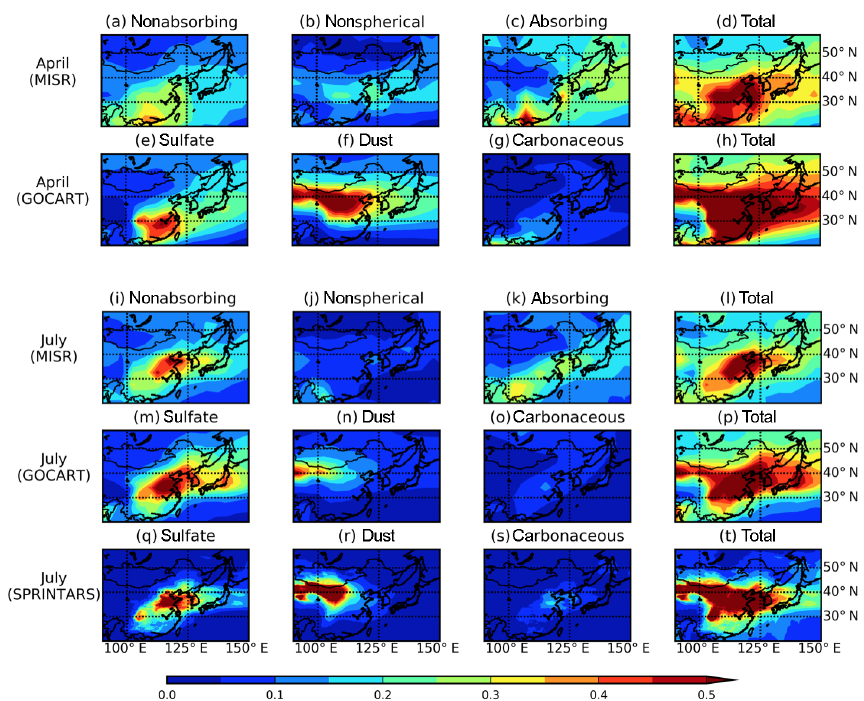
Figure 3. Maps of average MISR optical depth of spherical nonabsorbing aerosols, nonspherical, spherical absorbing aerosols, and total aerosols in April (a – d) and July (i – l) . Maps of average GOCART optical depth of sulfate, dust, carbonaceous, and total aerosols in April (e – h) and July (m – p) . Maps of average SPRINTARS optical depth of sulfate, dust, carbonaceous, and total aerosols in July (q – t)